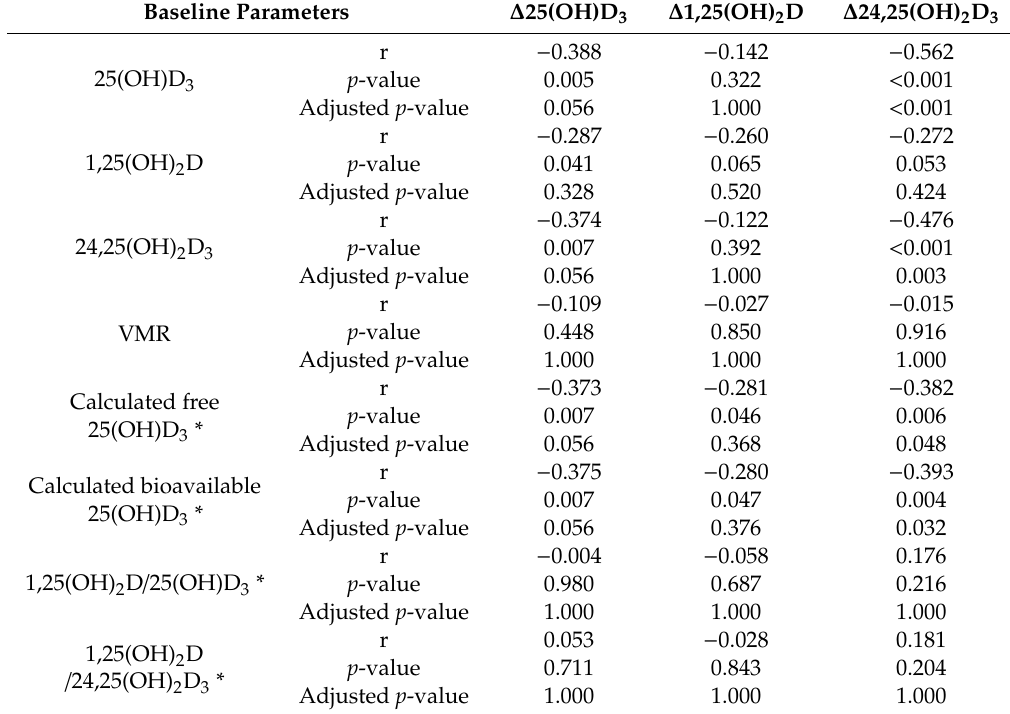
Table 3. Pearson correlations with unadjusted p -values and Bonferroni adjusted p -values of baseline vitamin-D-related parameters with the changes from baseline of 25(OH)D 3 , 1,25(OH) 2 D and 24,25(OH) 2 D 3 after vitamin D